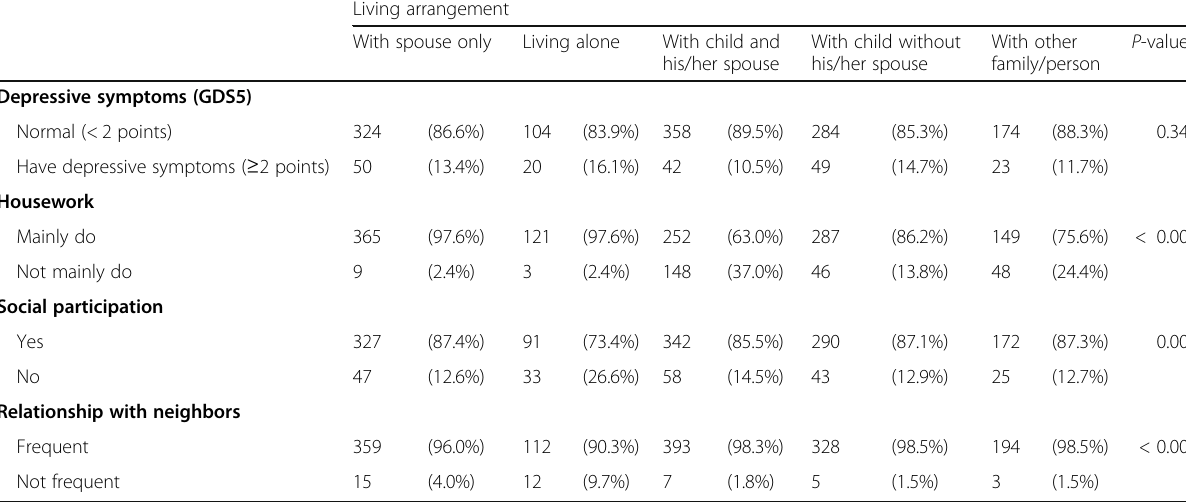
Table 1 Characteristics of the study population at baseline (Continued) Living